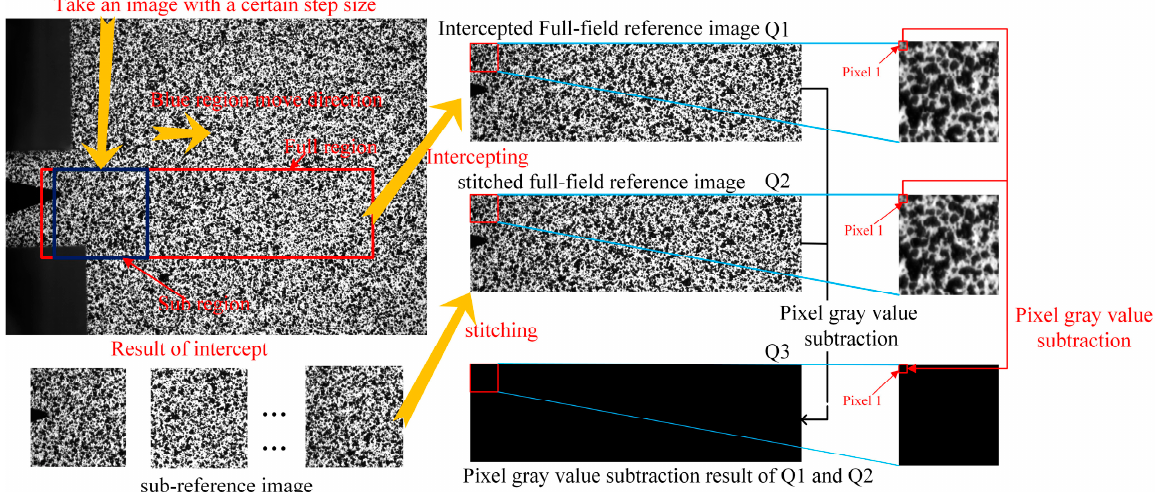
Figure 14. Verification process of image stitching. The correctness verification process of template matching is shown in Figure 15.